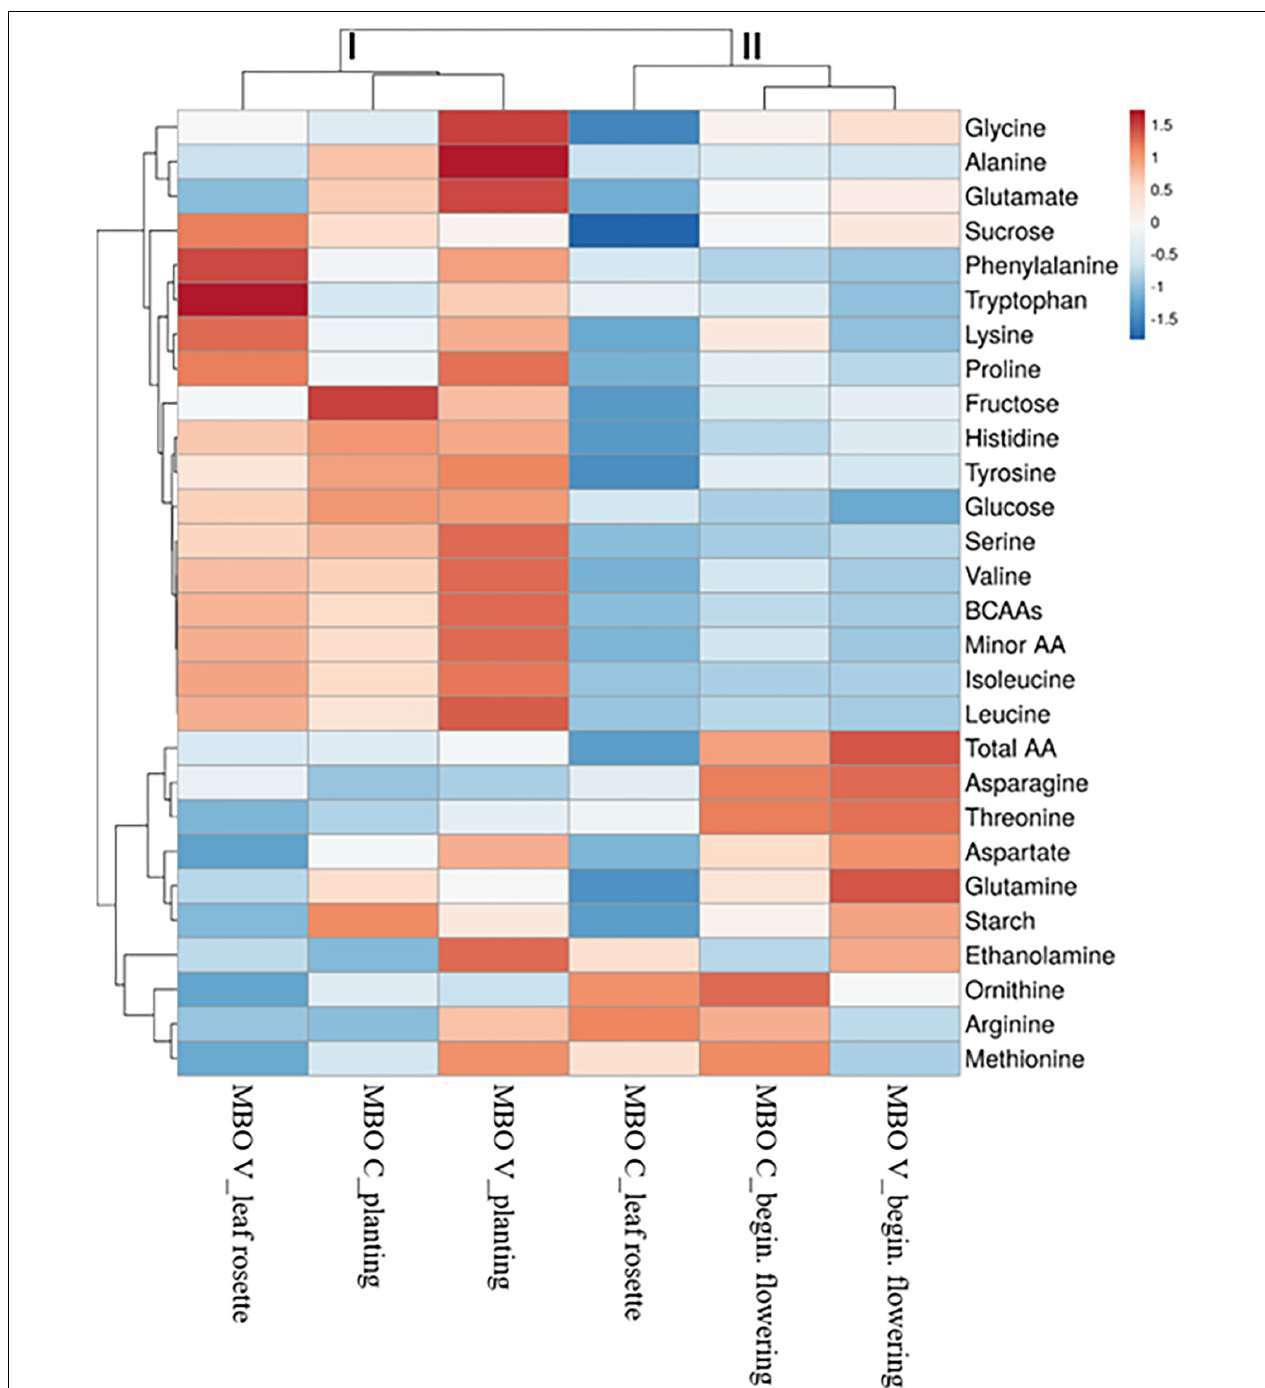
FIGURE 5 | Cluster heat map analysis summarizing sugars and free amino acid changes in tuberous roots at three plant phenological stages (planting, leaf rosette and beginning of flowering) of Ranunculus asiaticus L. hybrid MBO, in response to two preparation procedures of tuberous roots, only rehydration (Control, C) and rehydration followed by vernalization